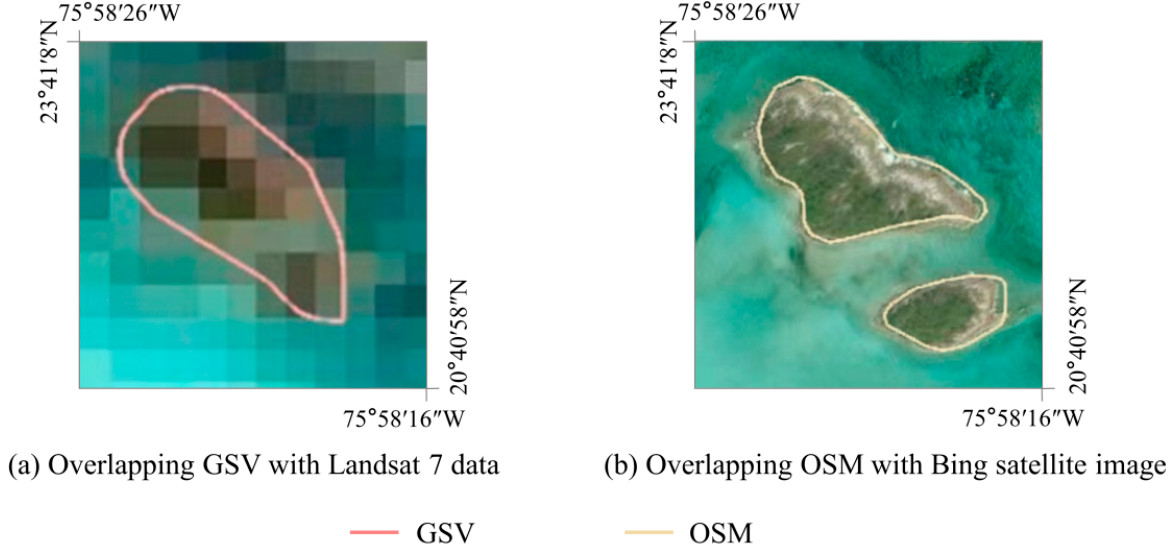
Figure 11. Overlapping the islands in the GSV and OSM datasets with Landsat 7 ( a ) and Bing satellite map ( b ), respectively.